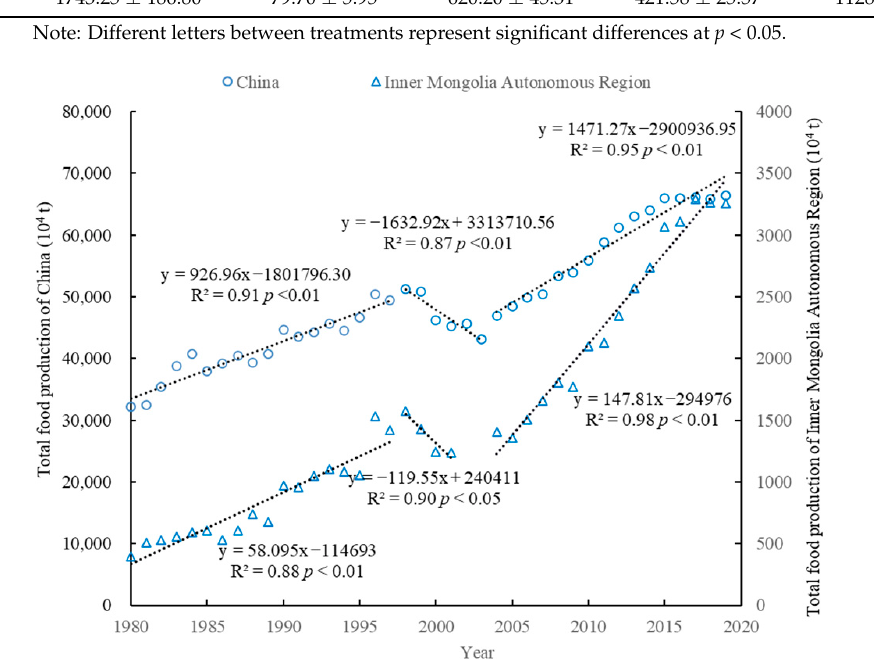
Figure 5. National and regional comparison of the grain production of different crops from 1980 to 2019.